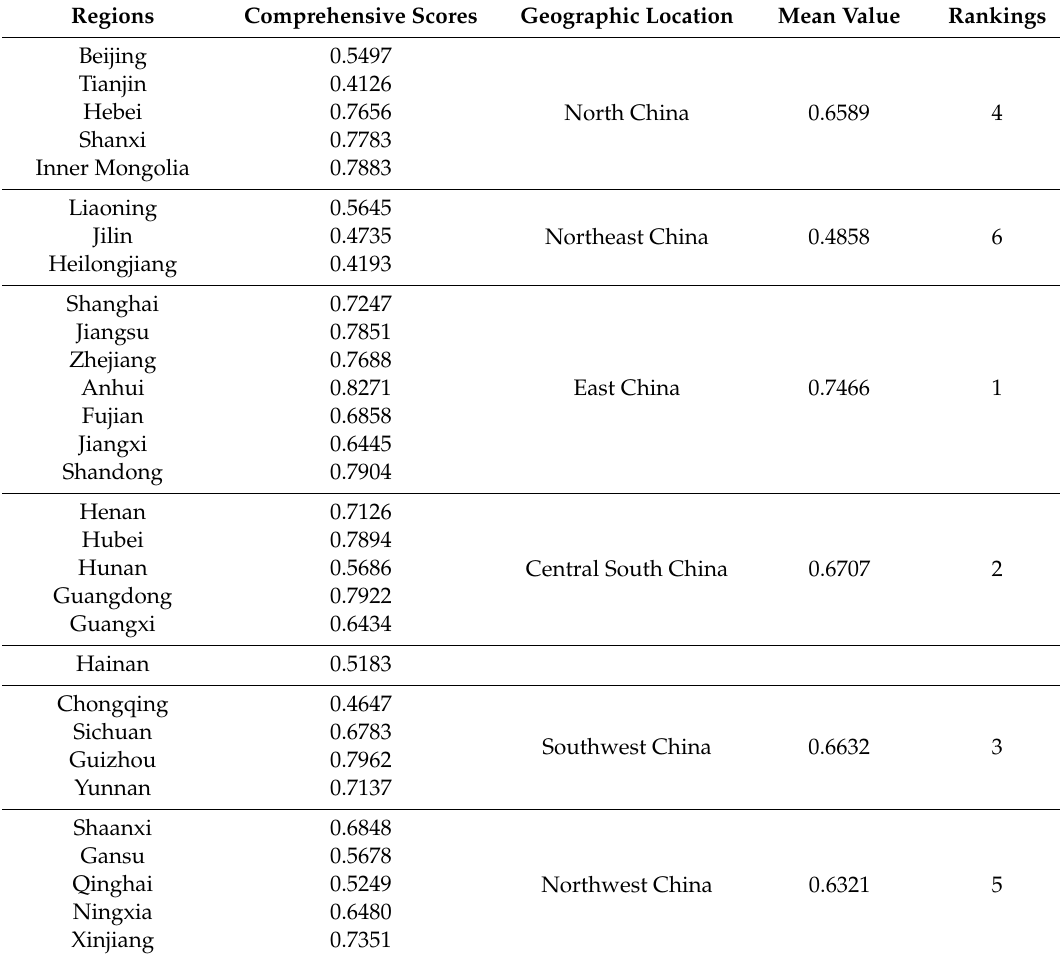
Table 7. Mean value and rankings of six major